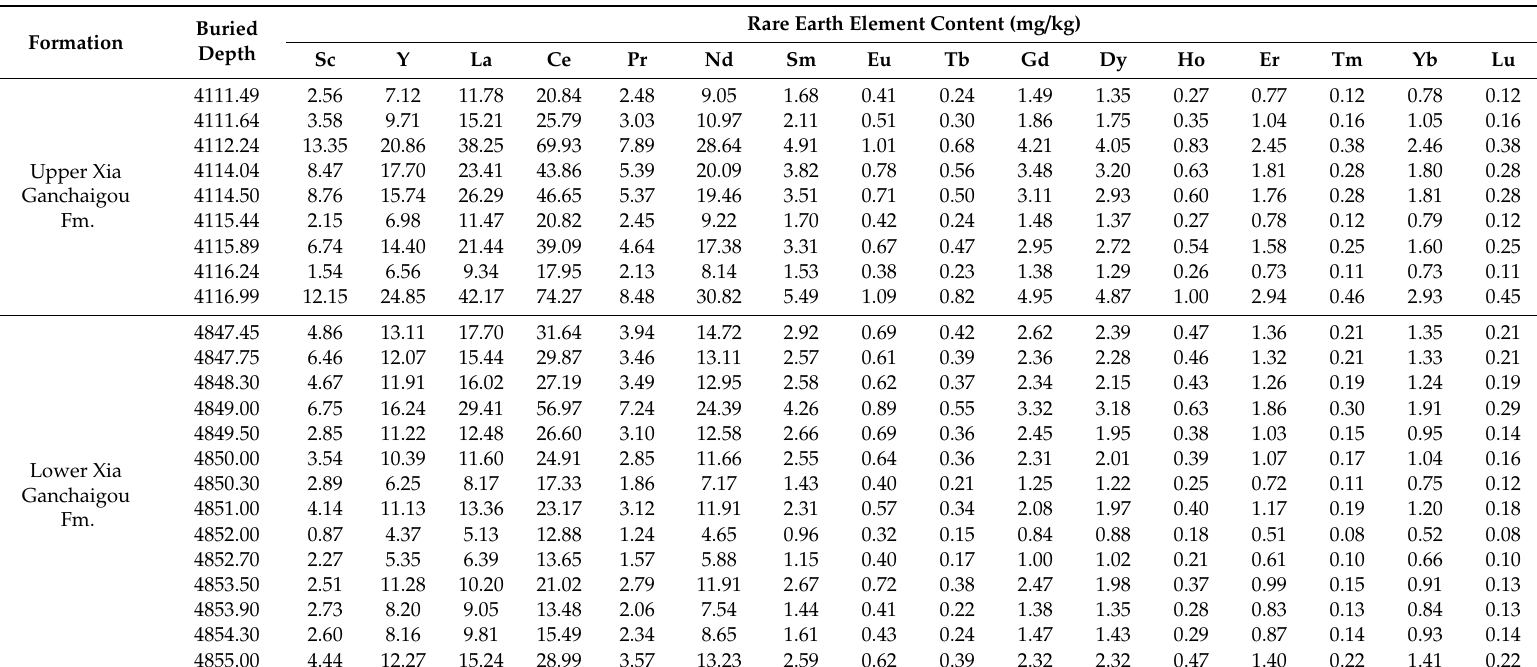
Table 4. Rare earth element content of the Xiaganchaigou Formation in the Lenghuqi